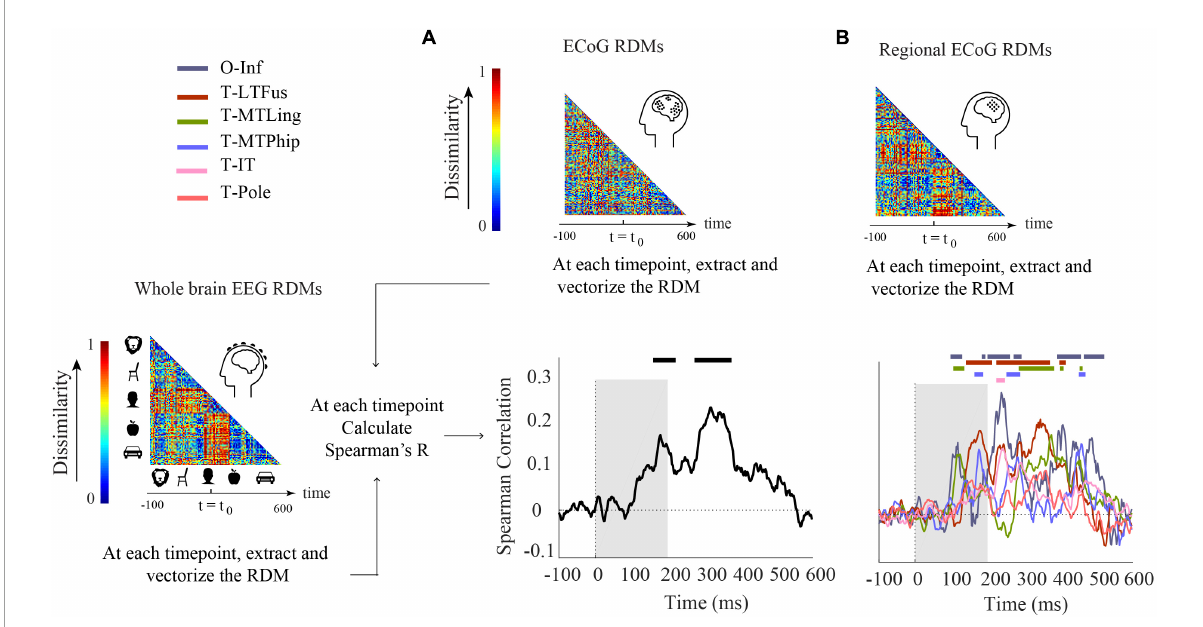
FIGURE3 Comparison of EEG and ECoG by representational similarity. We compared the EEG RDM (mean over participants) to (A) the ECoG RDM, constructed using all electrodes from all participants and (B) the regional ECoG RDM, constructed from electrodes limited to specific ROIs. The horizontal lines above the curves indicate significant time points (permutation test over stimuli, 10,000 iterations, FDR-corrected at p < 0.05). The ROIs include occipital-inferior (O-Inf), fusiform (T-LFus), lingual (T-MLing), parahippocampal (T-MTPhip), inferior-temporal (T-IT), and pole-temporal cortex